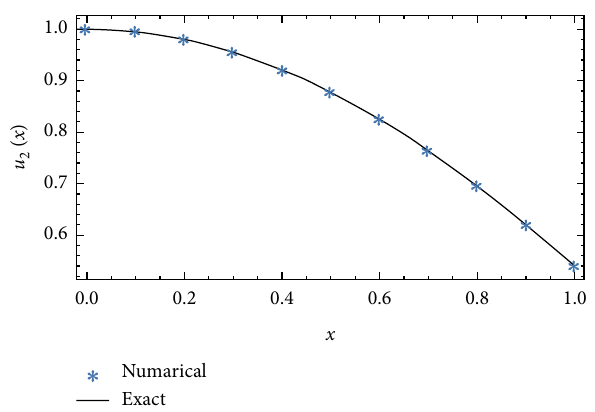
Figure 7: The exact and numerical solutions of 2 for system